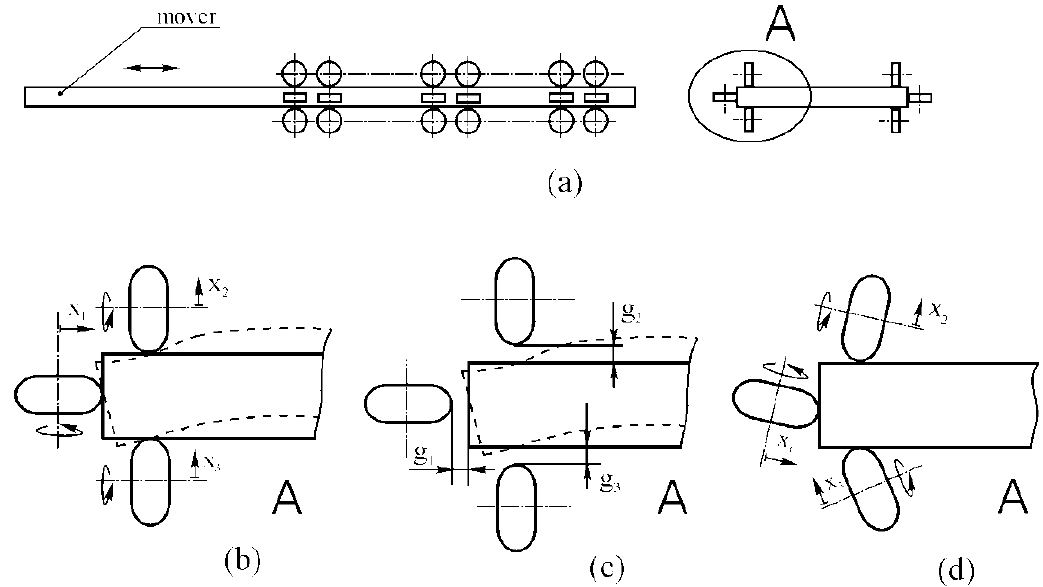
Figure 37: (a) Mover and cam follower bearings, (b) rectilinear degrees of freedom x 1 , x 2 , and x 3 of three cam follower bearings, (c) ad- justable clearances g 1 , g 2 , and g 3 , (d) perpendicularity errors of the cam follower